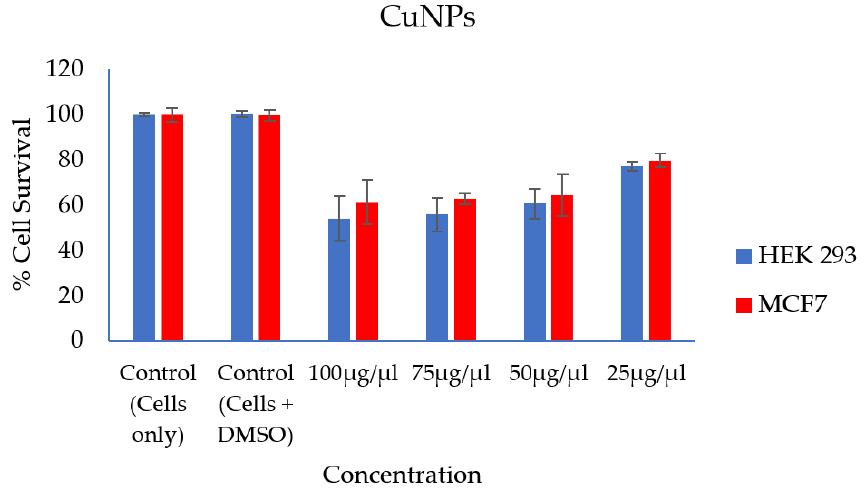
Figure 7. In-vitro cytotoxicity e ff ect of CuNPs nanoparticles on HEK293 and MCF7